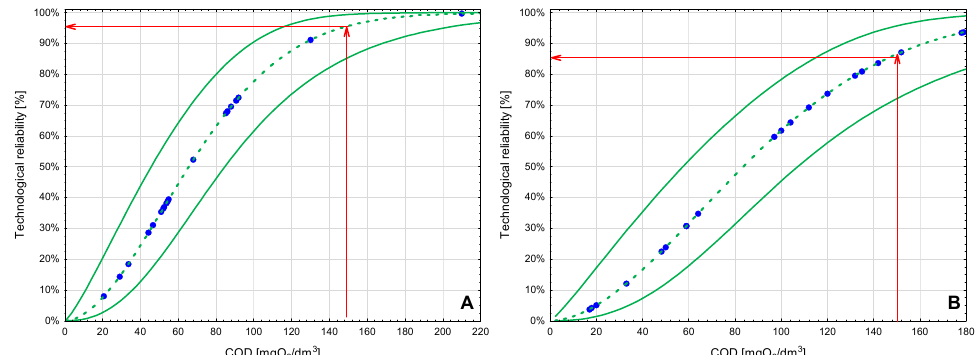
Figure 5. Weibull cumulative distribution functions and the technological reliabilities determined for COD (( A )—facility no. 1; ( B )—facility no. 2). Notation : dashed green line—reliability function, continuous green line—confidence intervals, red arrows—probability of achieving the indicators limit in the effluent.